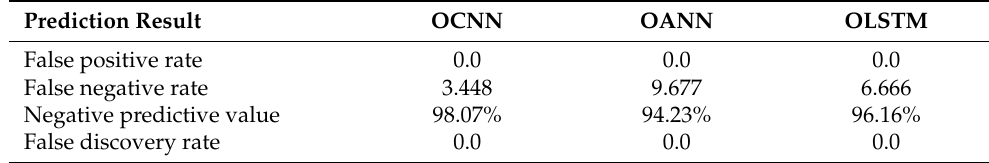
Table 5. Evaluation of prediction